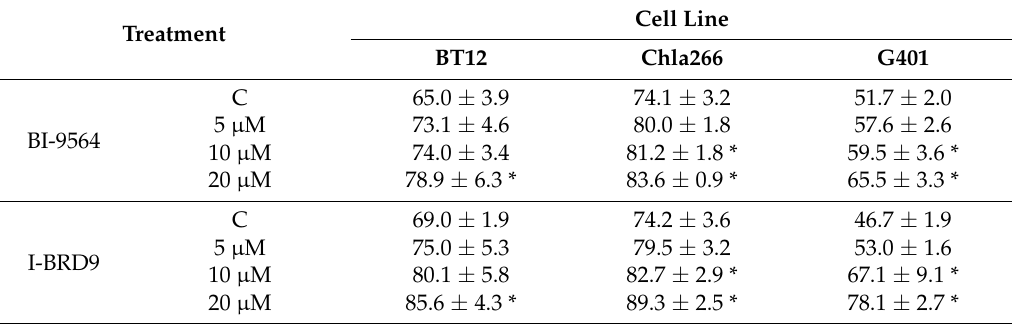
Table 2. Percentage of cells in G1 cell cycle phase after incubating with BI-9564 and I-BRD9 at the indicated concentrations for 72 h. ( n ≥ 3; mean ± SD; * treatment vs. control with p < 0.05, one-way ANOVA).